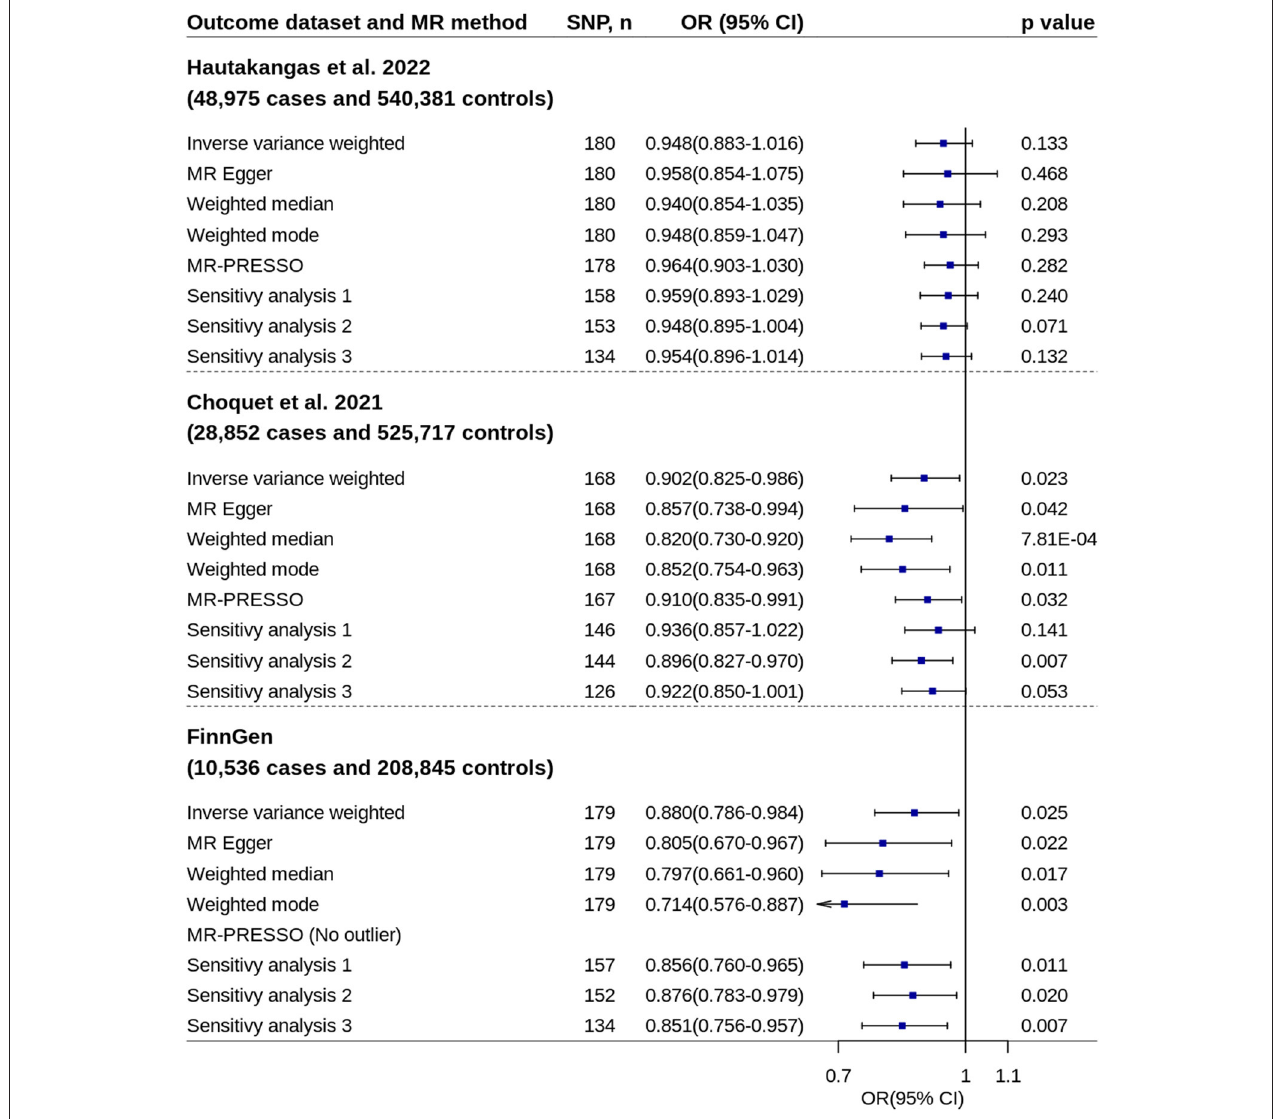
FIGURE 2 | Mendelian randomization analyses of 25OHD on migraine risk. Sensitivity analysis 1: SNPs associated with potential confounders were excluded. Sensitivity analysis 2: Potential reverse causal SNPs were excluded (Steiger-filtered analysis). Sensitivity analysis 3: All SNPs excluded in sensitivity analysis 1 and sensitivity analysis 2 were excluded. 25OHD, 25-hydroxyvitamin D; CI, confidence interval; MR, Mendelian randomization; MR-PRESSO, MR-Pleiotropy Residual Sum and Outlier; OR, odds ratio; SNP, single nucleotide